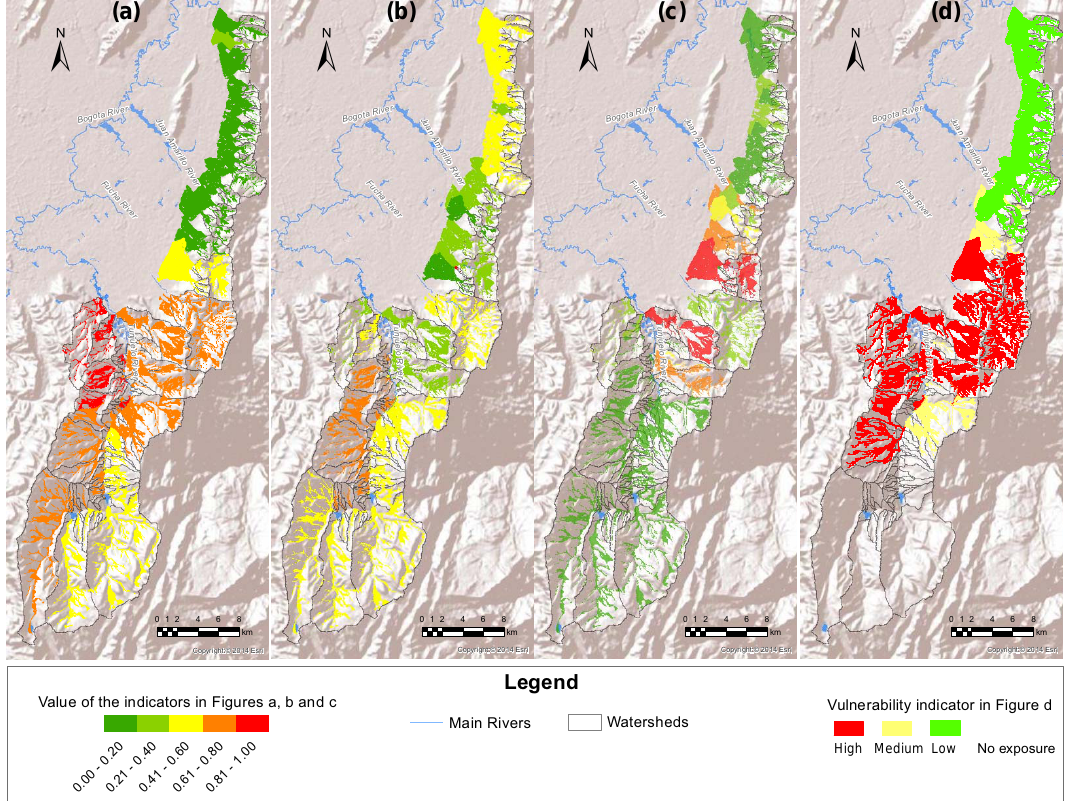
Figure 5. (a) Spatial distribution of the Socio-economic indicator; (b) Spatial distribution of the resilience indicator; (c) spatial distribution of the physical exposure indicator; (d) Spatial distribution of the total vulnerability